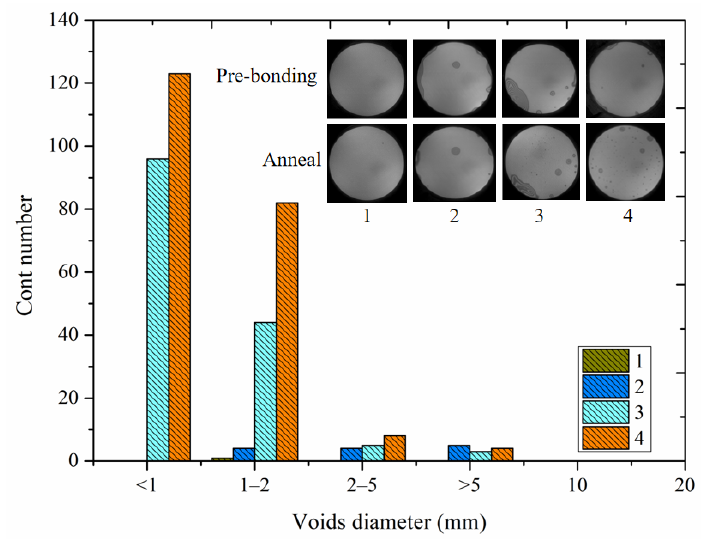
Figure 5. The size of the interfacial voids and the IR images for samples 1–4 obtained by different O 2 plasma activation parameters.